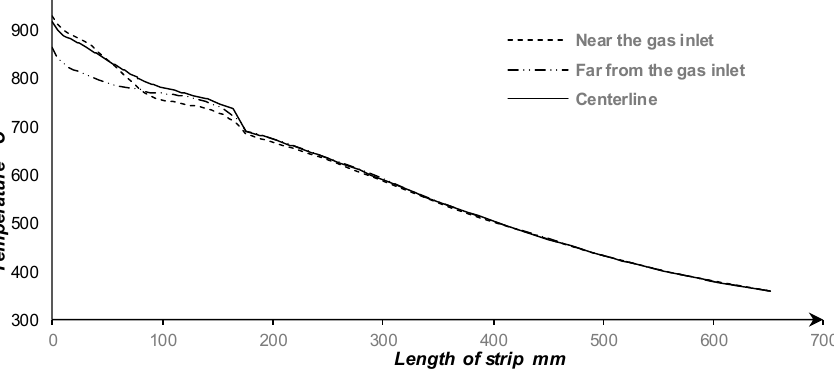
Figure 10. Predicted temperature trajectories along the two edges and at the center of the strip.